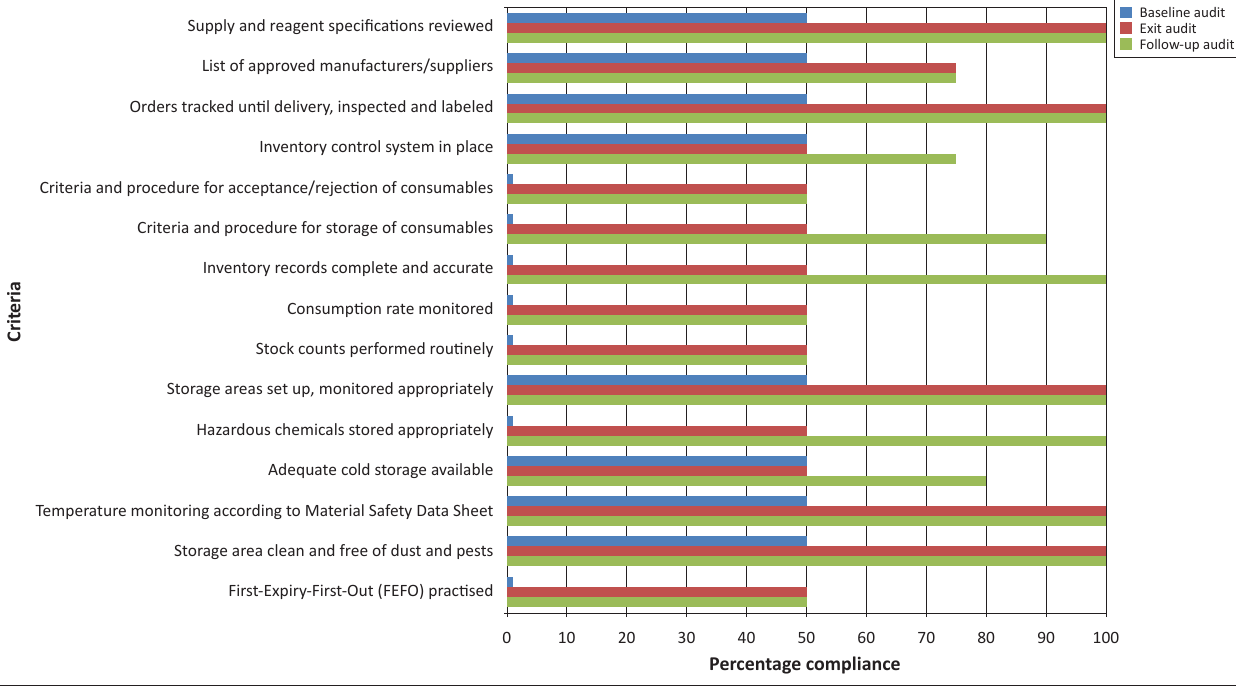
FIGURE 5: Improvement in laboratory stock management in Laboratory